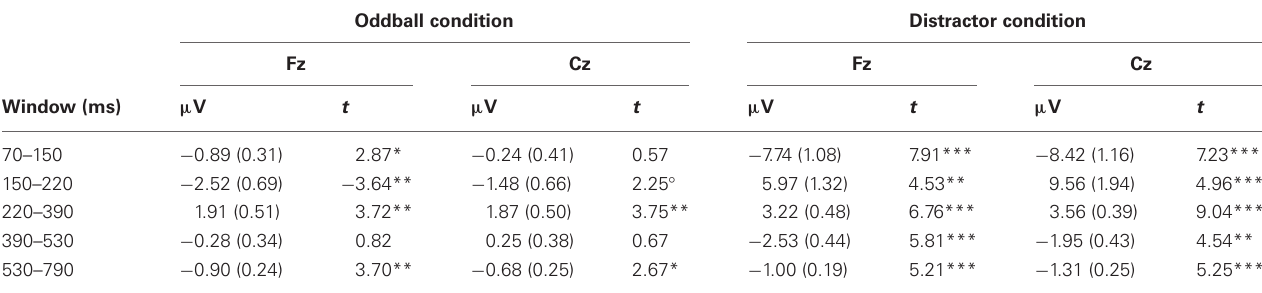
Table 1 | Mean amplitudes (and standard error of mean) and t -statistics of deviance related differences between rare and frequent trial separately for the five time windows at Fz and Cz in Experiment